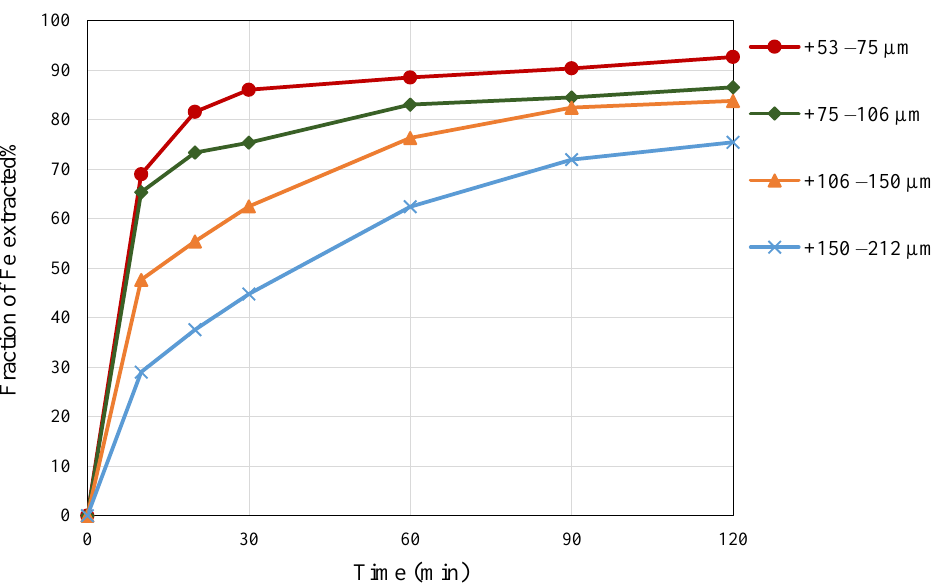
Figure 7. The effect of particle size on Fe extraction as a function of time. Conditions: 3 M nitric acid, temperature 65 °C, S/L ratio 1 to 20.